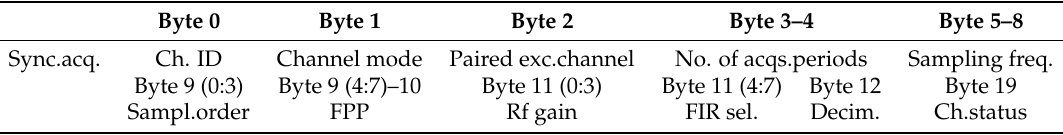
Table 3. AccessoryConfig attribute value packet structure for synchronous acquisitions